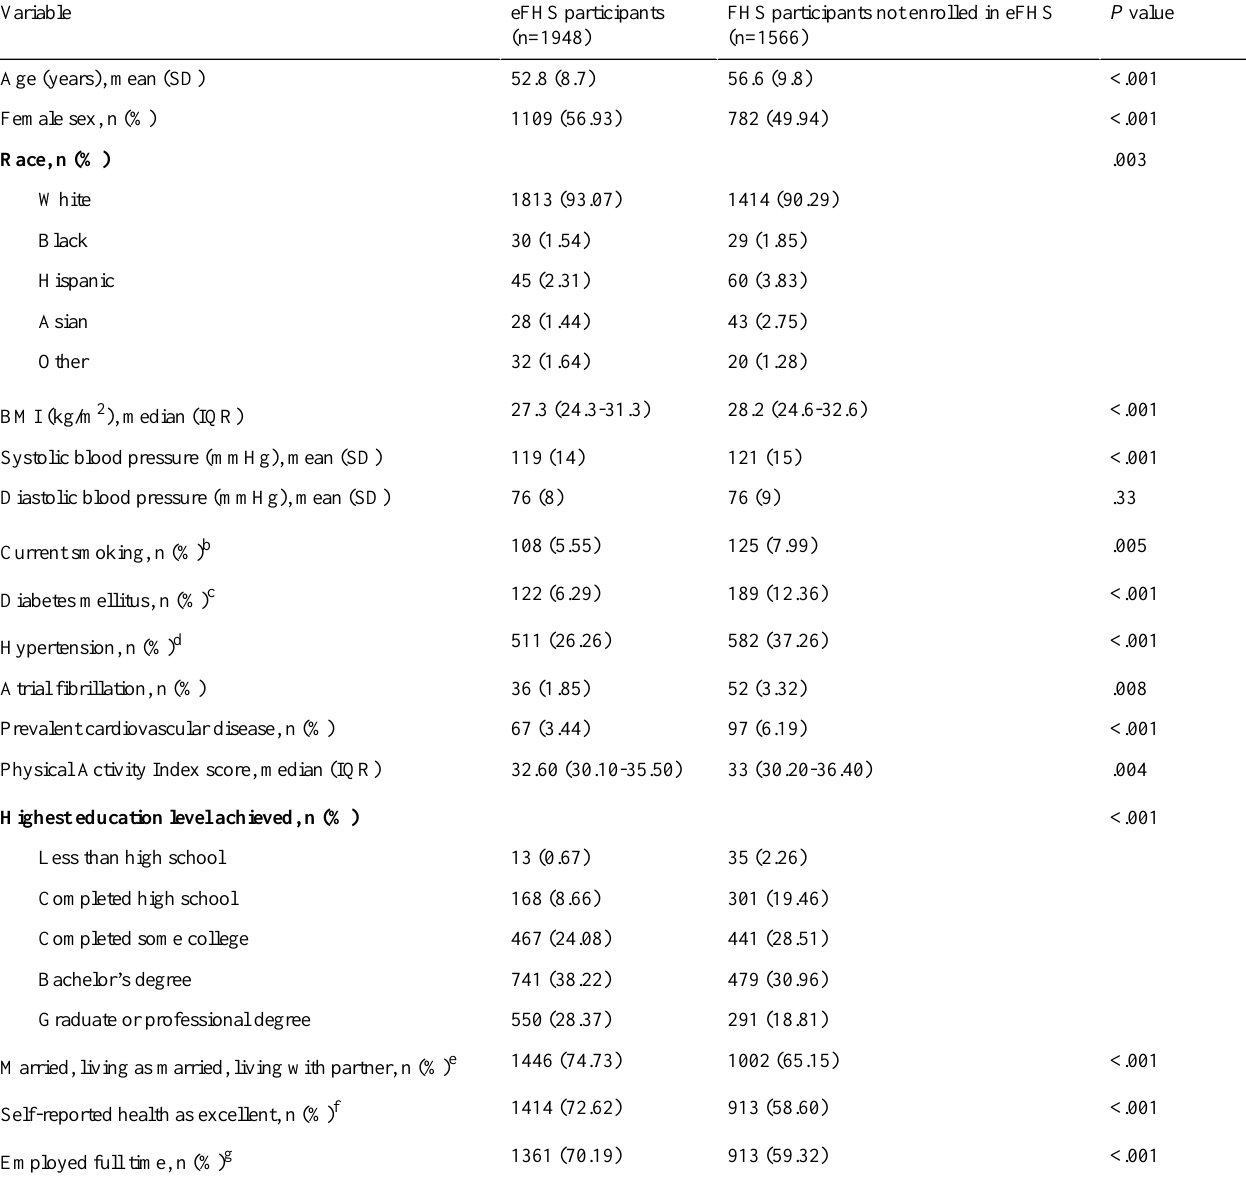
Table 1. Characteristics of participants in the eCohort Framingham Heart Study (eFHS) and Framingham Heart Study (FHS) participants not enrolled in eFHS.